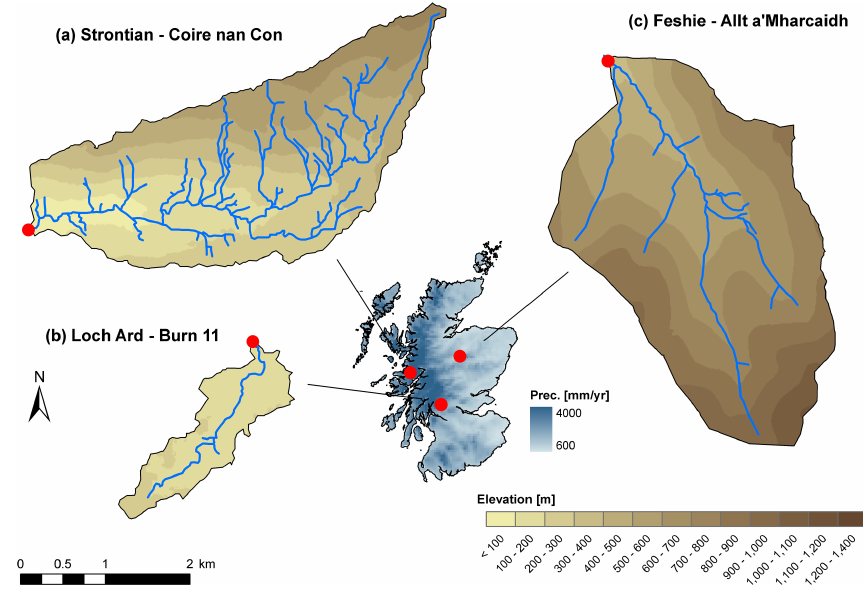
Fig. 1. Long-term mean annual precipitation and elevation maps of the 3 study catchments in the Scottish